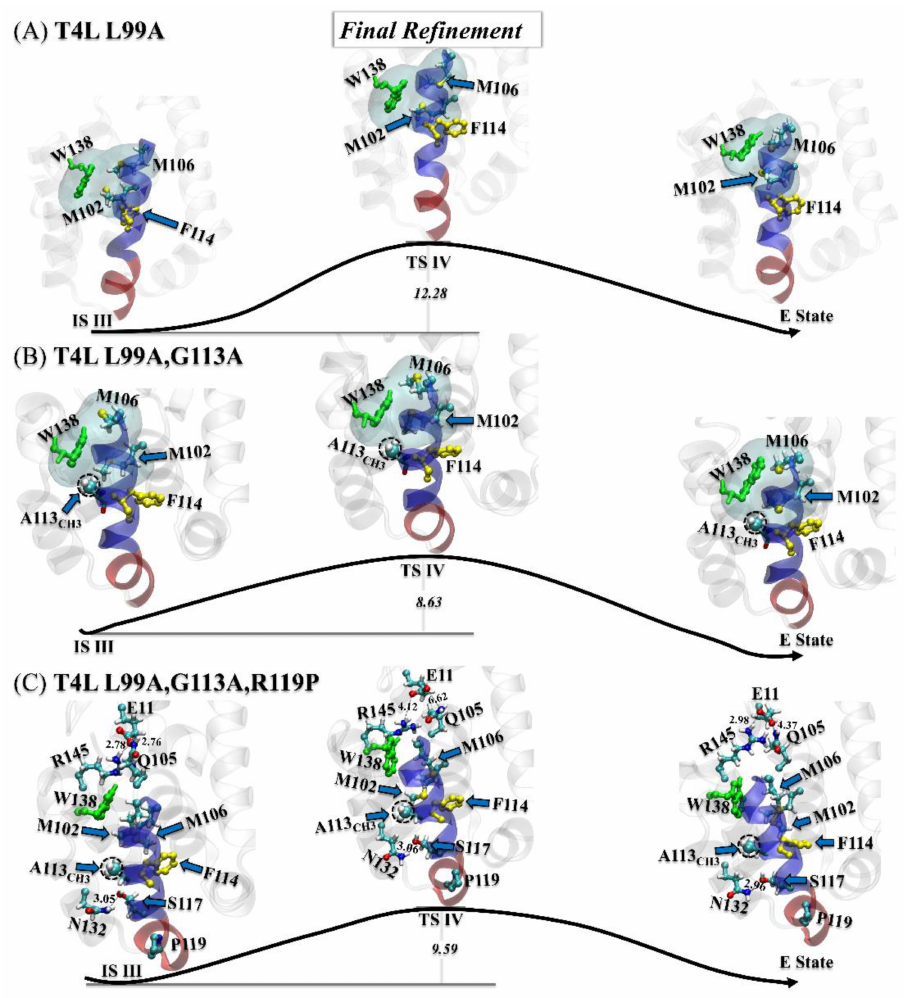
Figure 6. ( A – C ) Transition mechanisms of the third step (final refinement) of the G → E conversion for the T4L-L99A ( A ), the T4L-L99A,G113A ( B ), and the T4L-L99A,G113A,R119P ( C ). All transi- tion/intermediate states were identified from the free-energy landscapes in Figure 2A–C, with key residues and structural segments highlighted: α 0 (transparent blue), α 1 (transparent red), F114 (yel- low), W138 (green), and A113 CH3 (dashed black